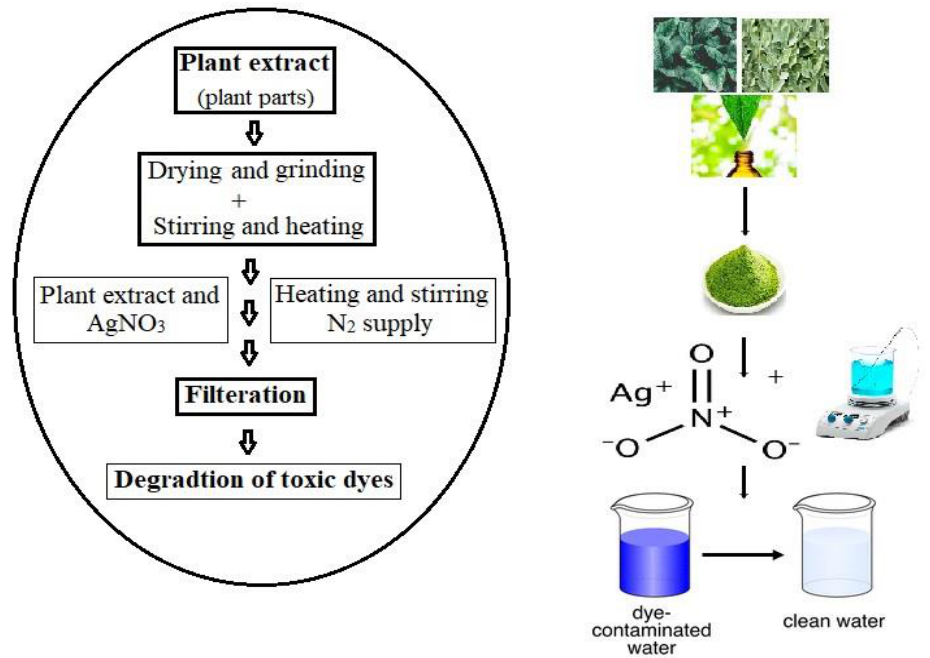
Figure 5. Diagrammatic representation of AgNPs (SNPs) from plant extract and their use as a dye degradation (adapted from [69]).